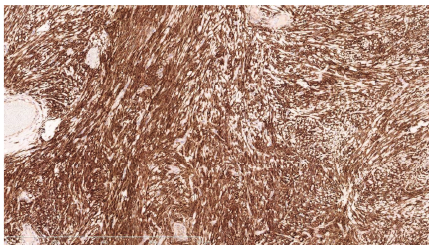
Figure 4: The spindle cells show strong and diffuse positivity for Bcl-2. × 100 magnification.